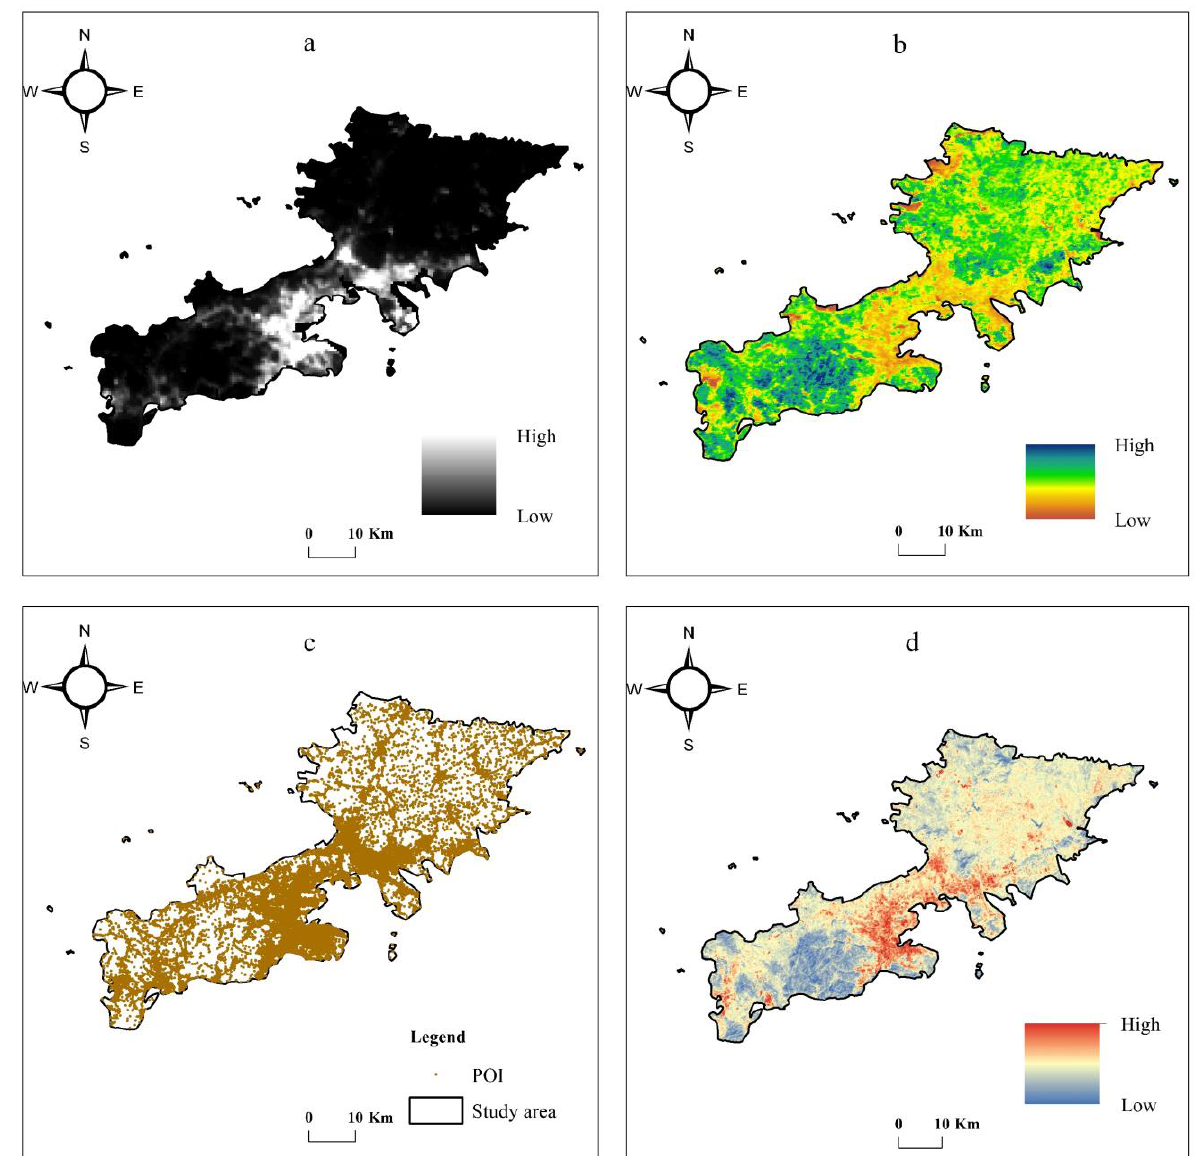
Figure 2. Experimental data: ( a ) NPP-VIIRS nighttime lighting data; ( b ) EVI data; ( c ) POI number; ( d ) LST data.